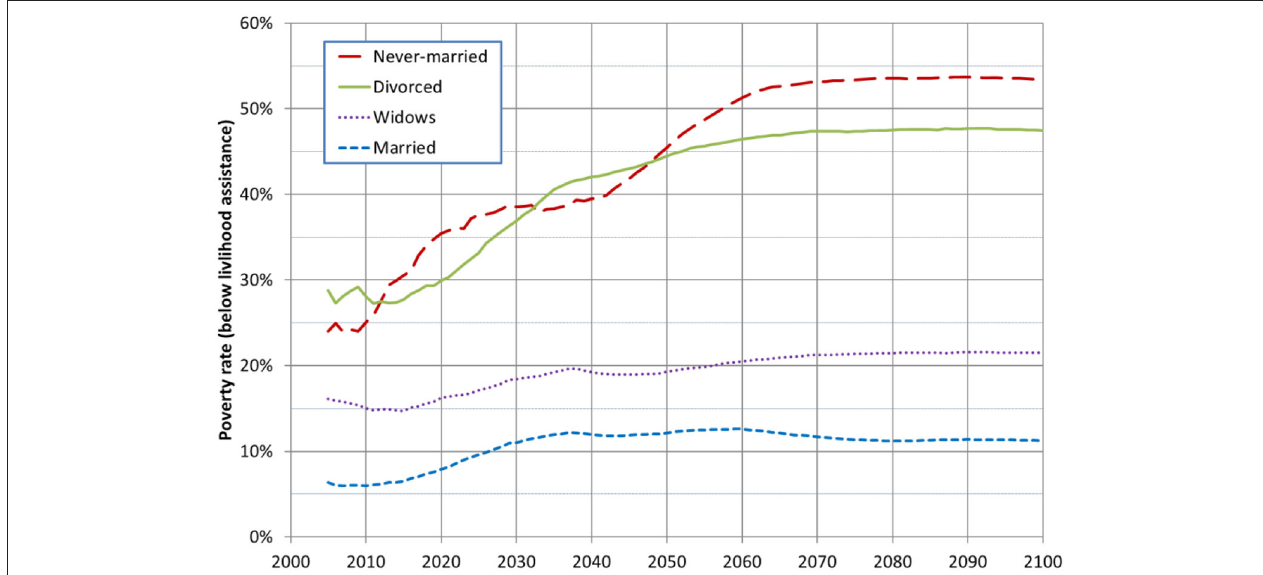
FIGURE 8 | Trends in poverty rates of elderly women by marital status. Simulation results.